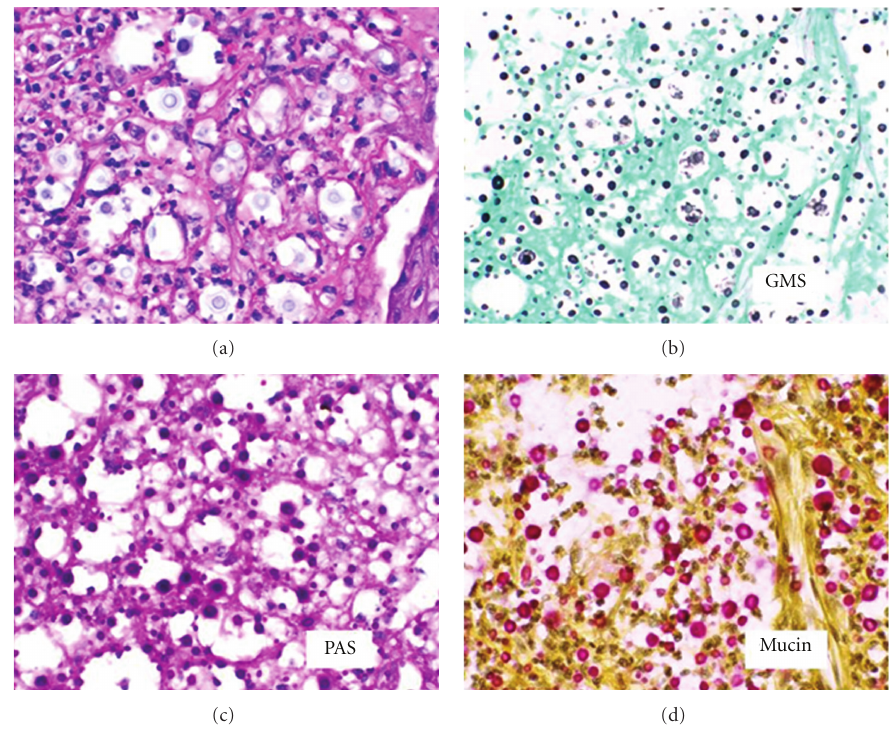
Figure 3: High-power (400x) view of the lesion with special stains for GMS, PAS, and